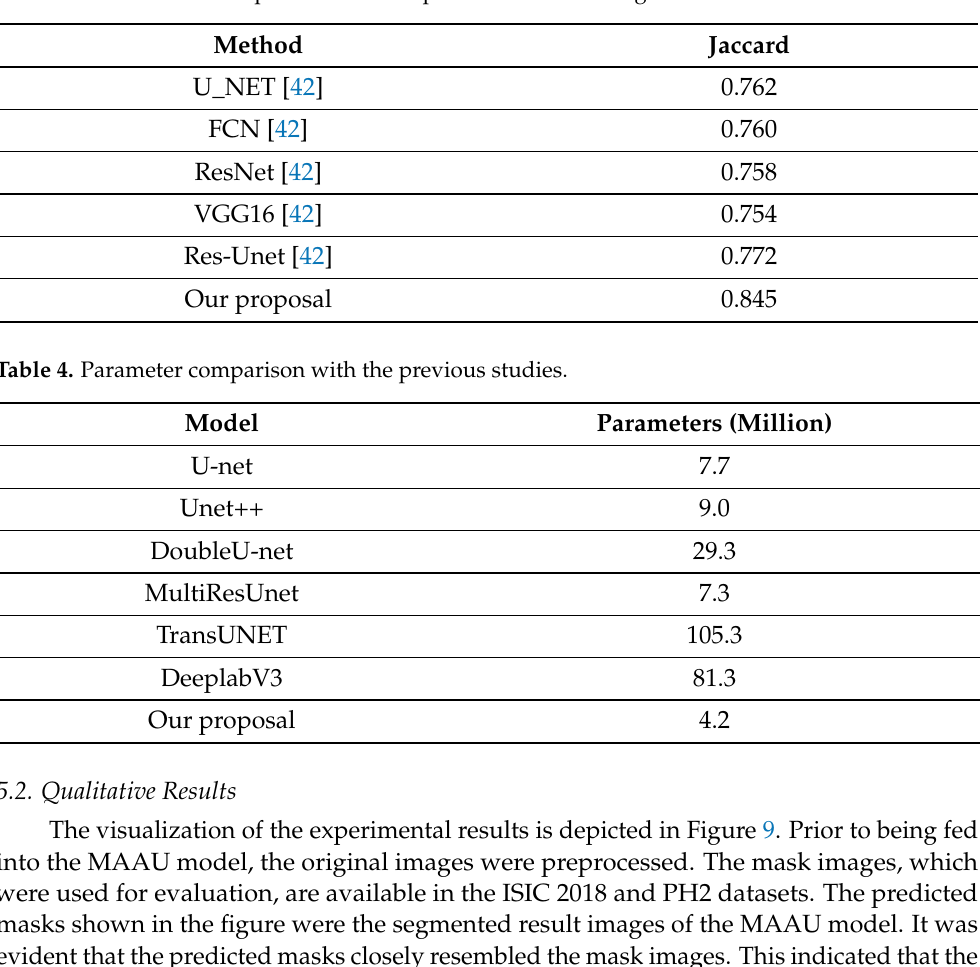
Table 3. Performance comparison with the previous studies using the PH2 dataset.